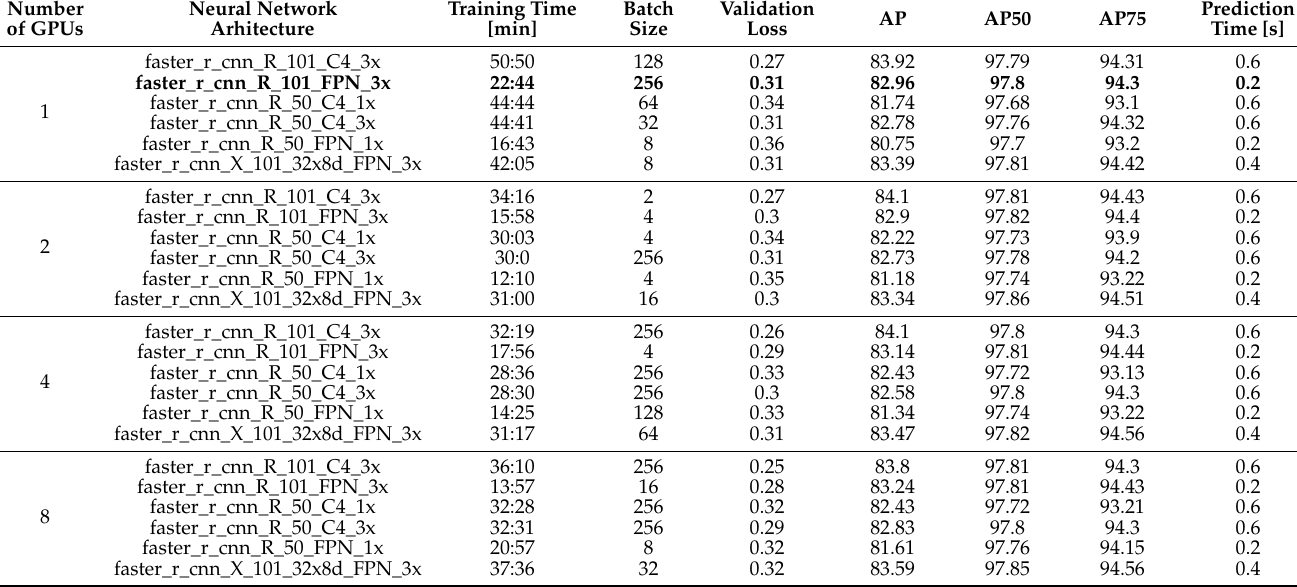
Table 1. Object detection: evaluation of different Faster R-CNN network architectures in Detectron2, gamma = 0.5, steps = 1000.